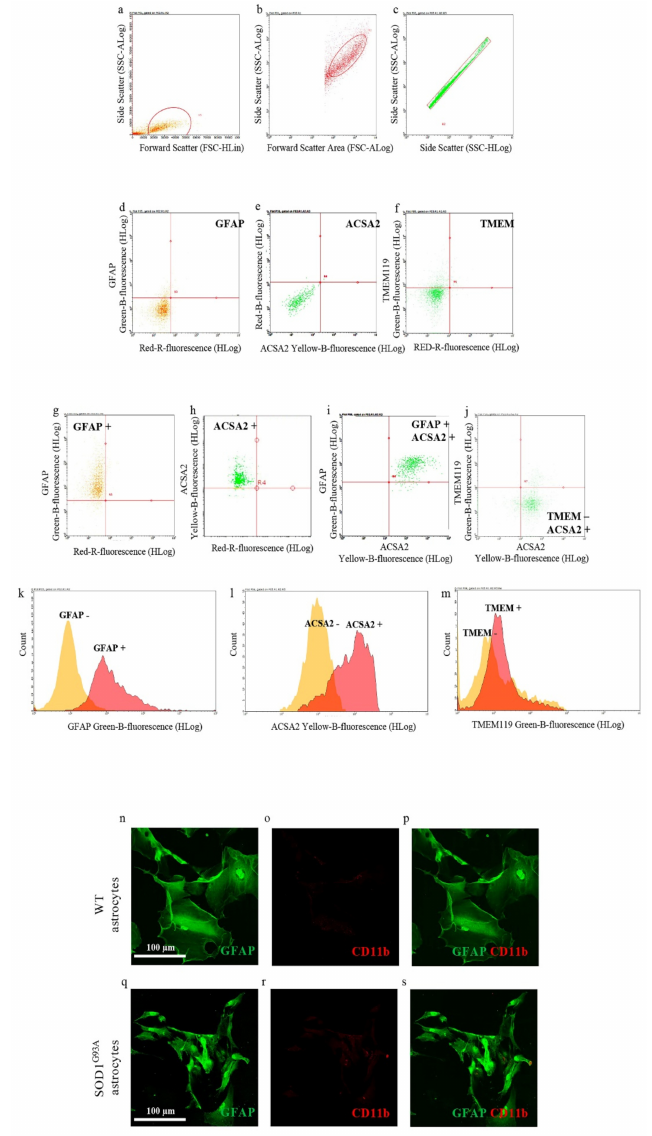
Figure 1. Astrocyte cell culture purity. Spinal cord neonatal astrocyte primary cell cultures were prepared from WT and SOD1 G93A P2 pups, and their purity has been verified by flow cytometry ( a – m ) and immunofluorescence ( n – s ). ( a – c ) Representative flow cytometry dot plots of SOD1 G93A astrocytes showing the cell population gated by ( a ) side scatter (SSC-ALog) vs. forward scatter (FSC- HLin), ( b ) SSC-ALog vs. forward scatter (FSC-ALog) and ( c ) SSC-Alog vs. side scatter (SSC-HLog). ( d – f ) Representative dot plots of SOD1 G93A unstained SOD1 G93A astrocytes. ( g – j ) Representative dot plots of SOD1 G93A astrocytes after incubation with fluorophore-conjugated antibodies for ( g ) GFAP (astrocyte marker; green fluorescence), ( h , i ) ACSA2 (astrocyte marker; yellow fluorescence) and ( j ) TMEM119 (microglia marker; green fluorescence). ( k – m ) Representative flow cytometry histogram plots of SOD1 G93A astrocytes showing the expression of ( k ) GFAP, ( l ) ACSA2 and ( m ) TMEM, compared to the respective unstained controls. For quantization, n = 4 biological replicates per group were analyzed. ( m – r ) Representative confocal microscopy images of WT and SOD1 G93A spinal cord neonatal astrocyte primary cell cultures stained with selective antibodies for ( n , q ) GFAP (green fluorescence) and ( o , r ) CD11b (specific microglia marker; red fluorescence); ( p , s ) merge panels. For quantization, n = 3 biological replicates per group were analyzed, with each value defined in